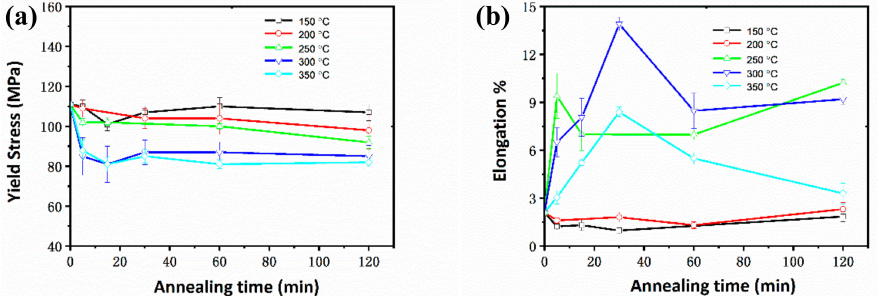
Figure 4. Tensile properties of pure Mg with di ff erent annealing treatments: ( a ) Yield strength; ( b )